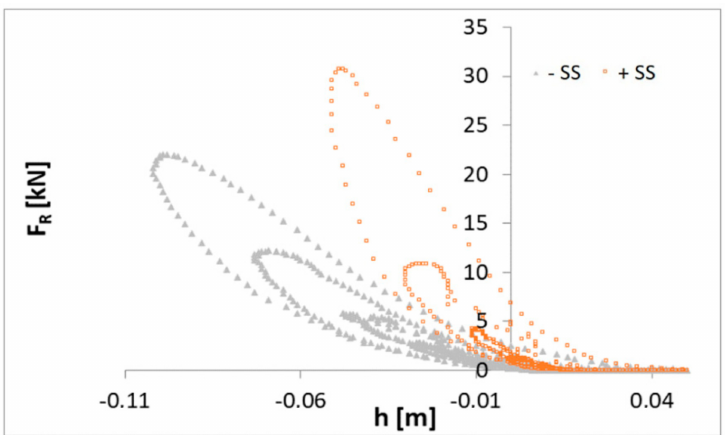
Figure 9. Influence of the support system on the correlation between the impact force F R and the height h.